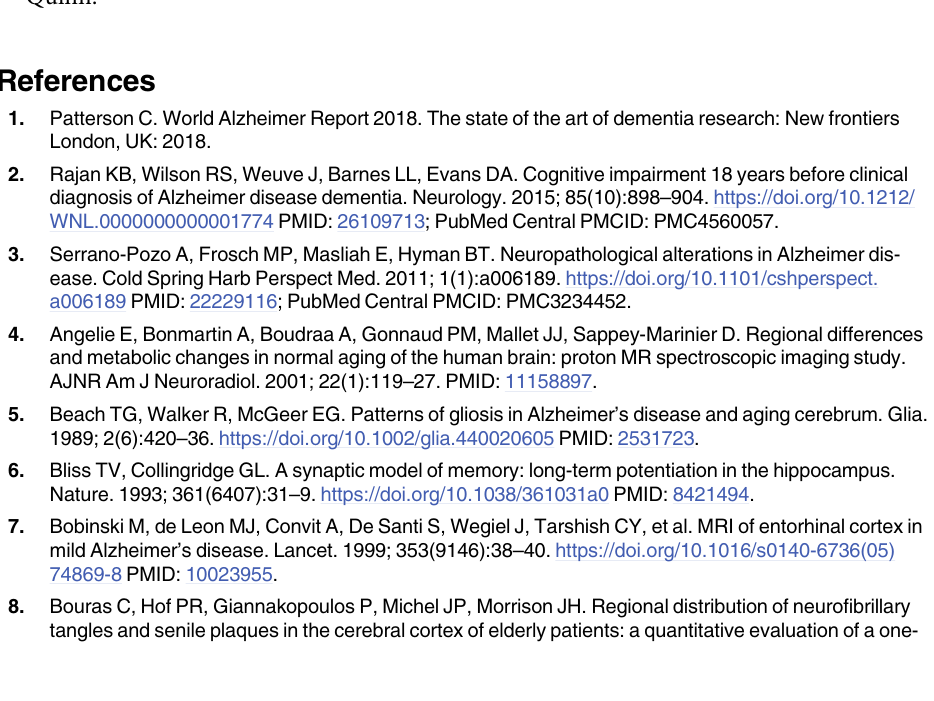
S7 Table. HIP and PCC SWIM genes venn diagram. S8 Table. Hippocampus pathway enrichment analysis. S9 Table. Posterior cingulate cortex pathway enrichment analysis. S10 Table. HIP/PCC pathway enrichment